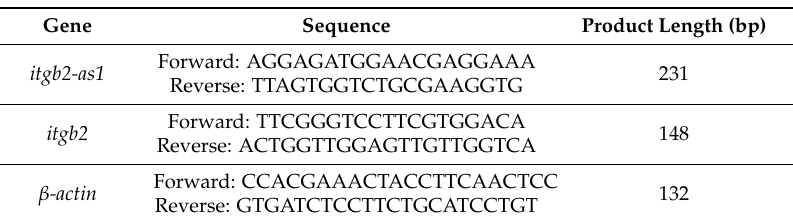
Table 1. Specific